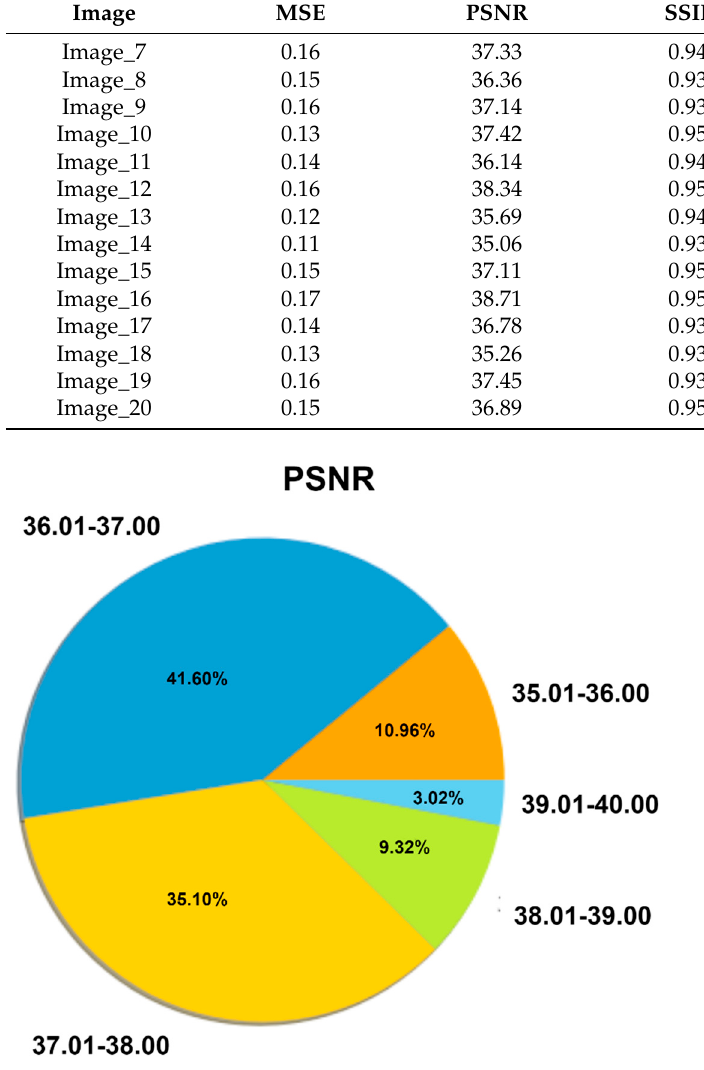
Figure 9. Pie chart of PSNR value for all 1932 ECG images.